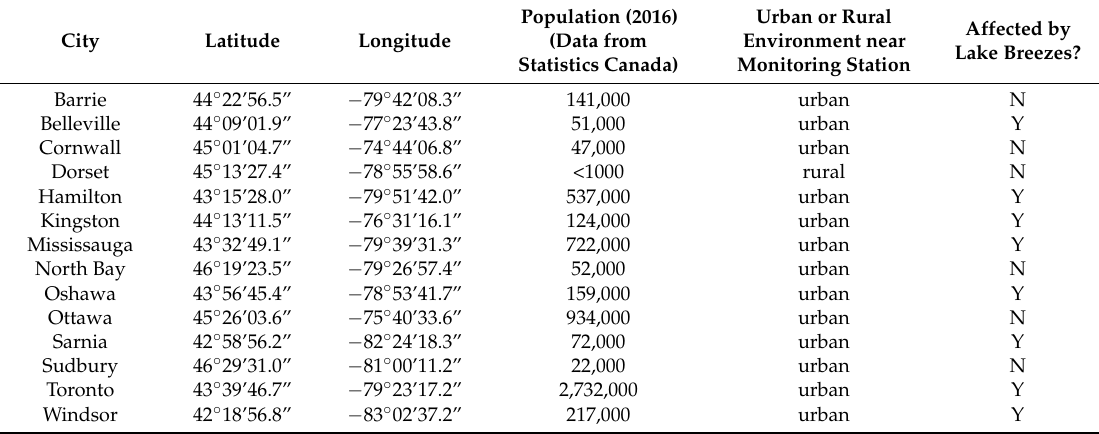
Table 1. Air quality monitoring locations in this